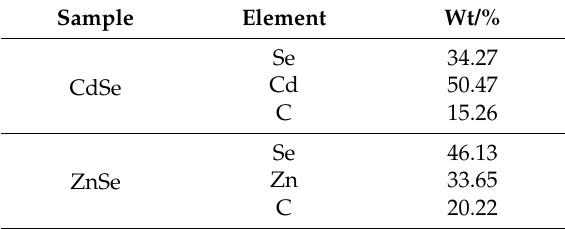
Table 1. Weight percentages of elements in CdSe and ZnSe nanoparticles